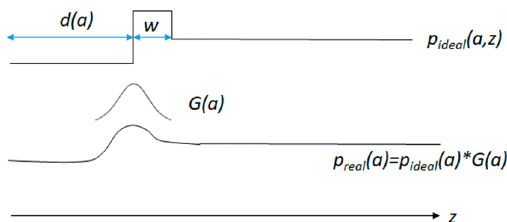
Figure 6. Computing the measured occupancy probability for a single ray for a given angle a . The obstacle is at the distance d ( a ), before the obstacle the area is considered free, and beyond the obstacle (of a minimum depth w ) the state of the cells is unknown. The distance measurement error is encoded in the Gaussian kernel G ( a ) that will convolve the probability array.